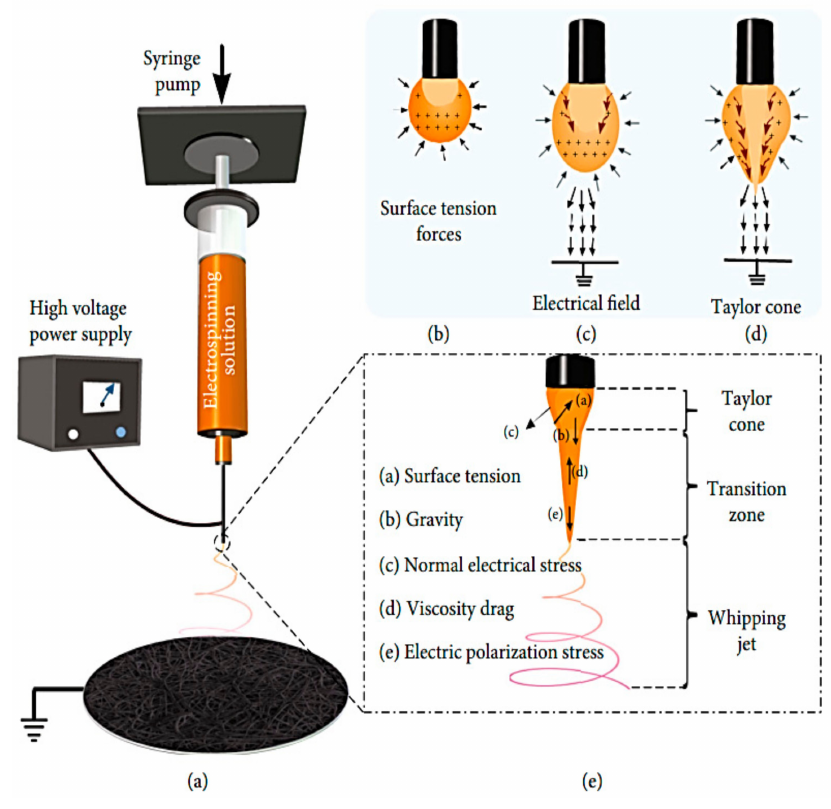
Figure 2. Typical electrospinning process setups